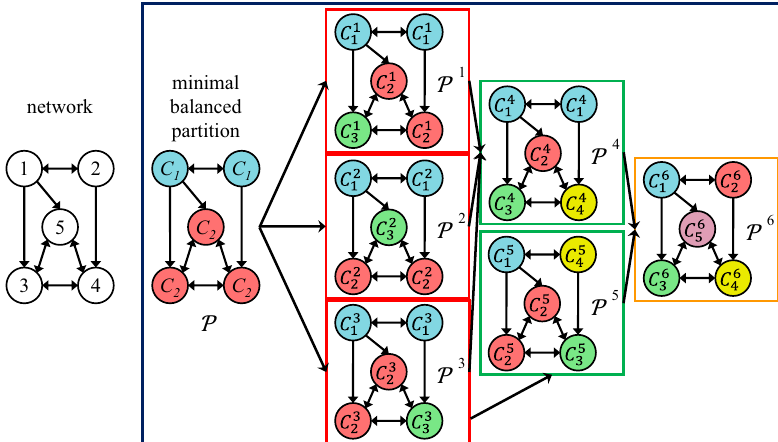
Fig. 2 Illustrative example with all balanced partitions. Balanced partitions (within the dark blue box) of a simple directed network with N = 5 nodes. The partition P corresponds to the minimal balanced coloring, with two clusters C 1 (containing nodes 1 and 2, colored blue) and C 2 (containing nodes 3 – 5, colored red): each node of cluster C 2 receives one arrow from one node of C 1 ; each node of cluster C 1 receives one arrow from one node of C 1 and two arrows from nodes of C 2 . Breaking these clusters, we can obtain all the other balanced partitions, which are non-minimal, because they contain a higher number of clusters. Each partition P 1 , P 2 , and P 3 (within red boxes) contains three clusters, which are obtained from P by breaking the largest cluster into two smaller ones. For instance, P 1 contains C 1 (with nodes 1 and 2, colored blue), C 1 (with nodes 4 and 5, colored red), and C 1 (with node 3, colored green). 1 2 3 This partition is balanced, because each node of C 1 receives one arrow from one blue node, each node of C 1 receives one arrow from a blue node, one arrow 1 2 from a red node and one from a green node, and each node of C 1 receives one arrow from a blue node and two arrows from red nodes. Similarly, partitions 3 P 4 and P 5 (within green boxes) contain four clusters each and are obtained from the partitions with three clusters by breaking the largest cluster into two smaller clusters: the partition P 4 is obtained by breaking the red clusters of P 1 , P 2 , or P 3 ; the partition P 5 is obtained by breaking the blue cluster of P 3 . Finally, the partition P 6 (within orange box) contains fi ve trivial clusters (each one includes only one